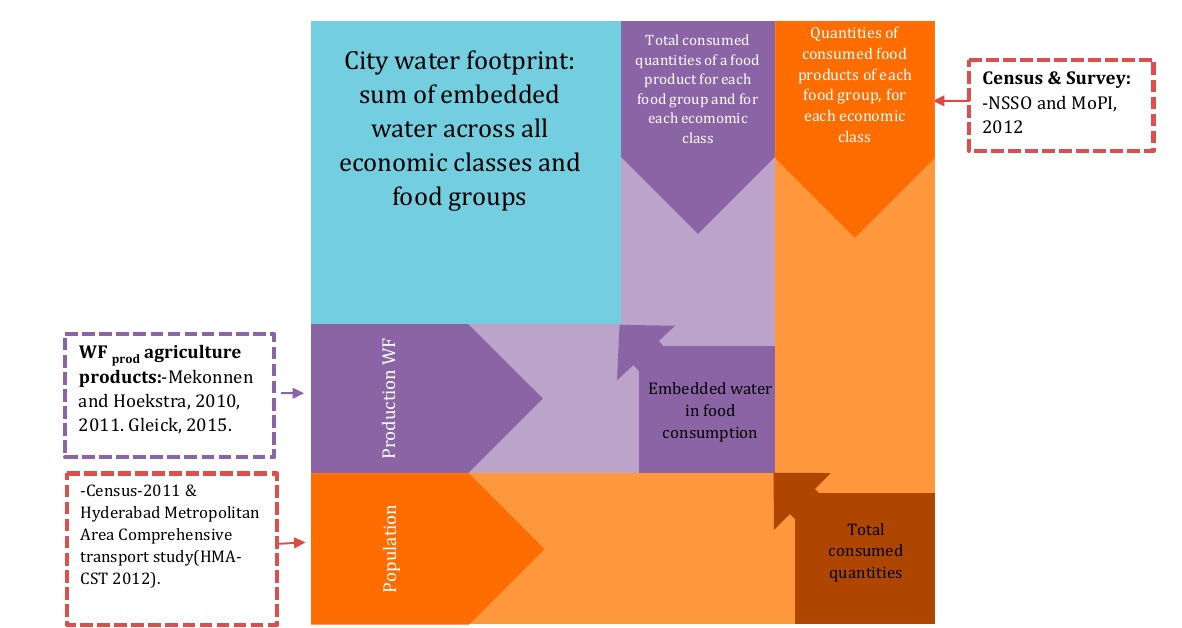
Figure 2 . The framework to account for water footprint and the data used to assess the water, food, and economic nexus of Hyderabad. The arrows indicate the direction of their multiplier to quantify the central elements: total food consumption quantities of a food product for each economic class, the embedded water content in food consumption for each food product and each economic class, and city-level embedded water contents in food consumption. WF: water footprint; NSSO: National Sample Survey Organization.